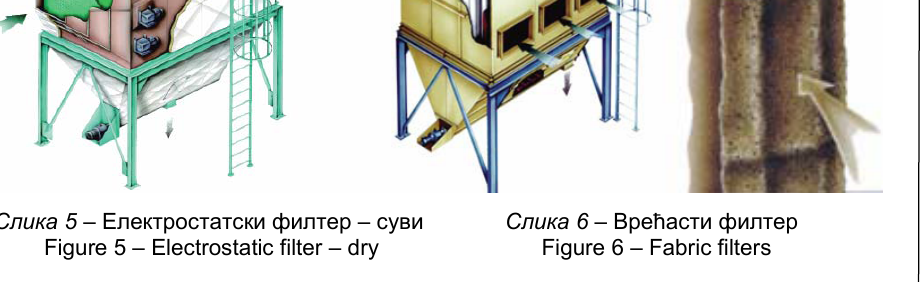
Figure 5 – Electrostatic filter – dry Figure 6 – Fabric